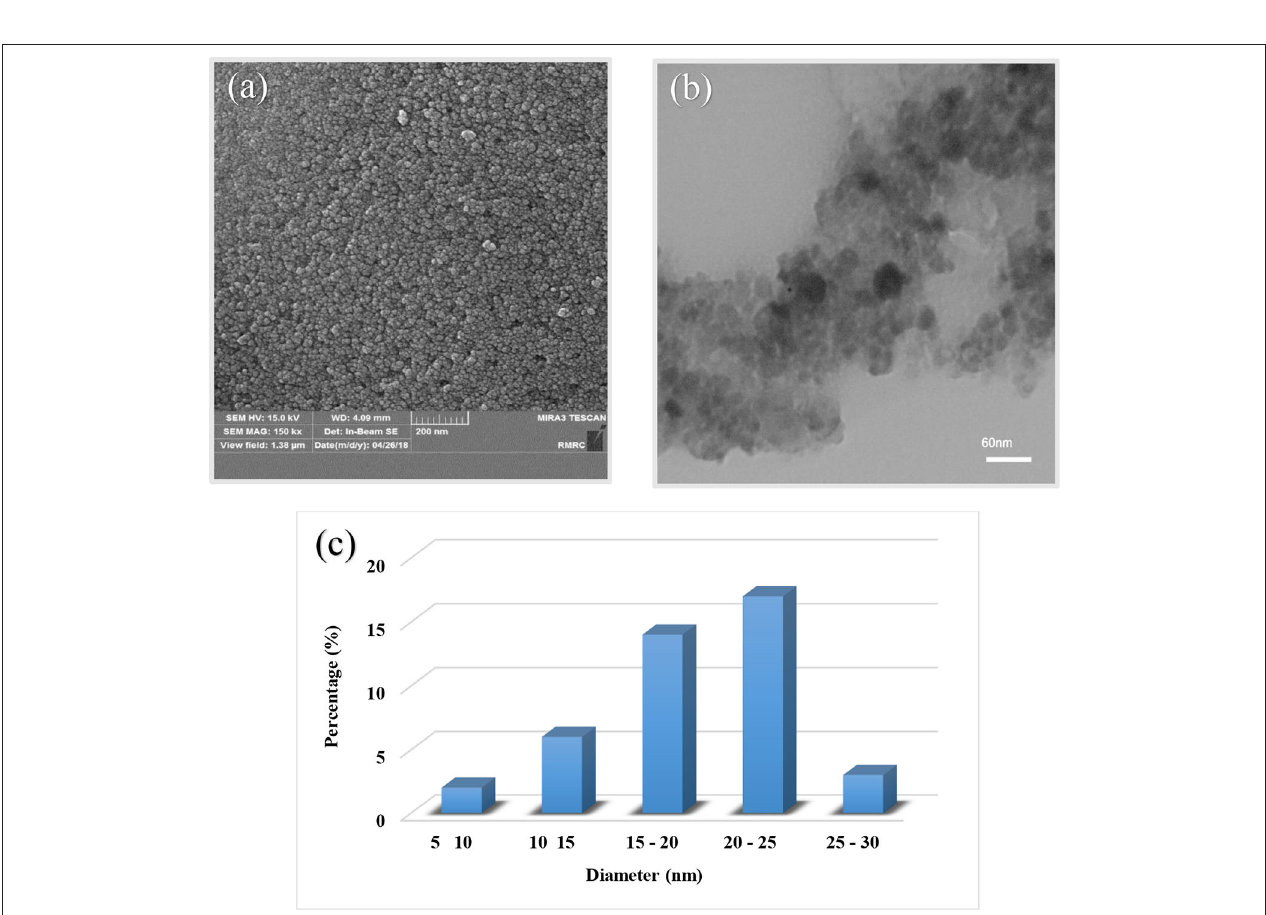
FIGURE 5 | SEM (a) and TEM (b) images of Fe 3 O 4 @PVA-Cu nanoparticles and size distribution of nanoparticles chart (c) .